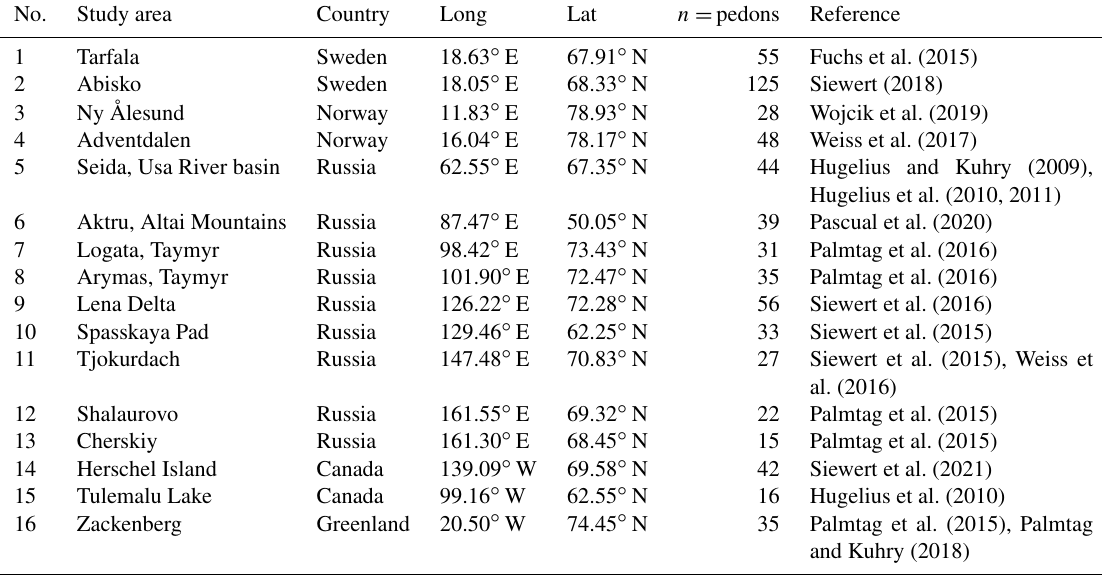
Table 1. Summary of all study sites.